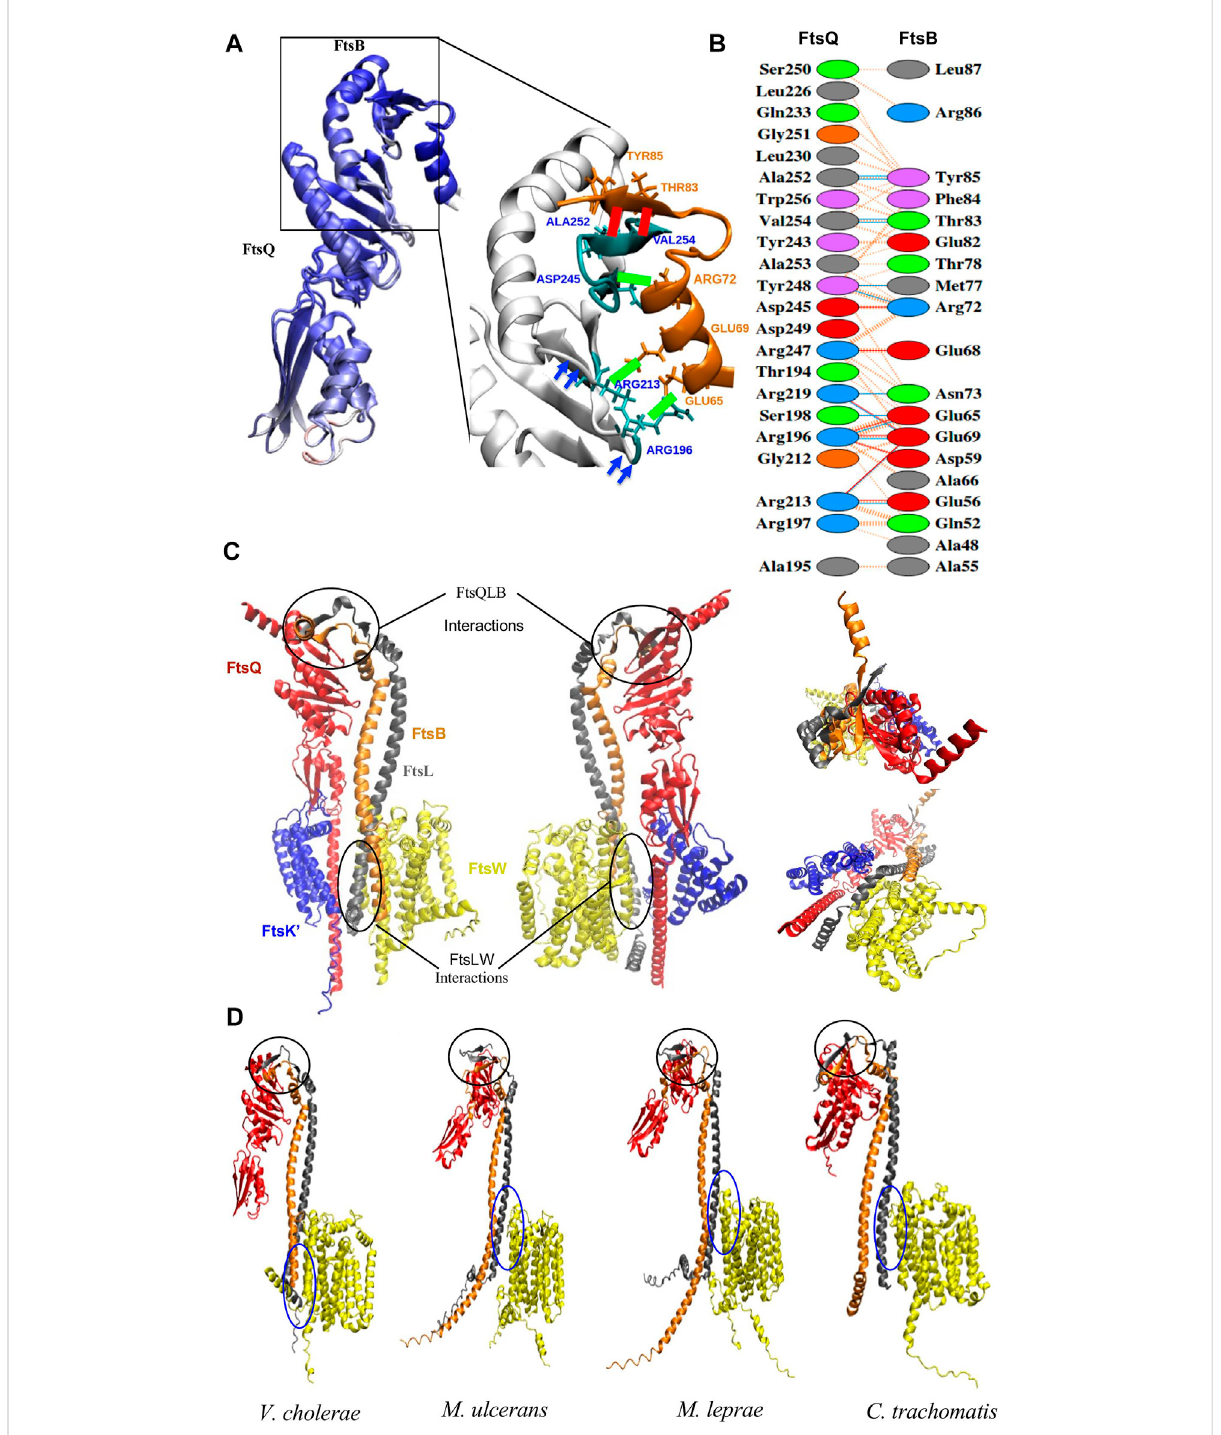
FIGURE 2 (A) SuperimpositionoftheecFtsQBPDBstructure(6H9N)withtheAlphaFoldpredictablemodelandarecoloredonthebasisofQresvalue.The black rectangle highlights the region of association between FtsQ and FtsB. The green colored bond represents the salt bridges and red colored bondsrepresentstheHydrogenbondsbetweentwoproteins.Theseinteractionsareconservedinboththestructures. (B) PDBsumoutputshowsthe interfacing residues for modeled FtsQB from E. coli . The red, blue, and orange colored lines represent salt bridge, hydrogen bonds and non- bonded interactions. (C) Front, back, top and bottom view of the AlphaFold prediction model of E. coli FtsK ’ QLBW divisome subcomplex; individual proteins are represented in different colors: FtsK ’ (blue), FtsQ (red), FtsL (gray), FtsB (orange), and FtsW (yellow). The black circles at the C-terminus highlights the binding regions between FtsQBL and towards N- terminus highlights those between FtsLW. (D) AlphaFold prediction model of the protein complex of FtsQ (Periplasmic domain), FtsL, FtsB, and FtsW in V. cholerae, C. trachomatis, M. leprae, and M. ulcerans. The black circle highlights FtsQBL and blue circle FtsLW binding regions